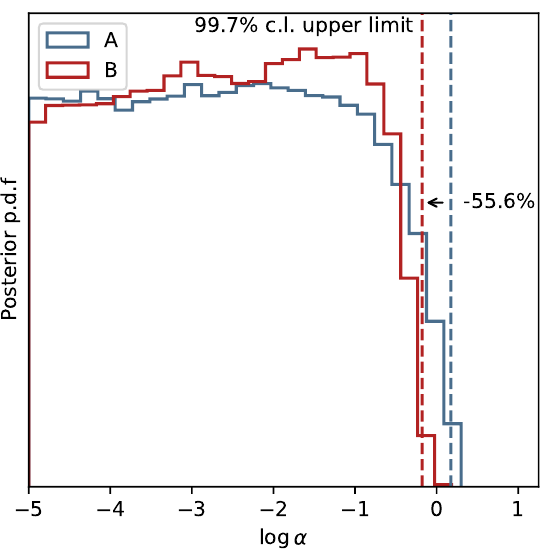
Figure 3. The normalized posterior probability distribution of the parameter α in logarithmic scale for the two analysis A (in blue) and B (in red). The 99.7% c.l. level upper limit of the parameter is reported as a dashed vertical line in the two cases. The analysis B provides a more peaked distribution for α around 0, with the upper limit going down by 55.6% between the two